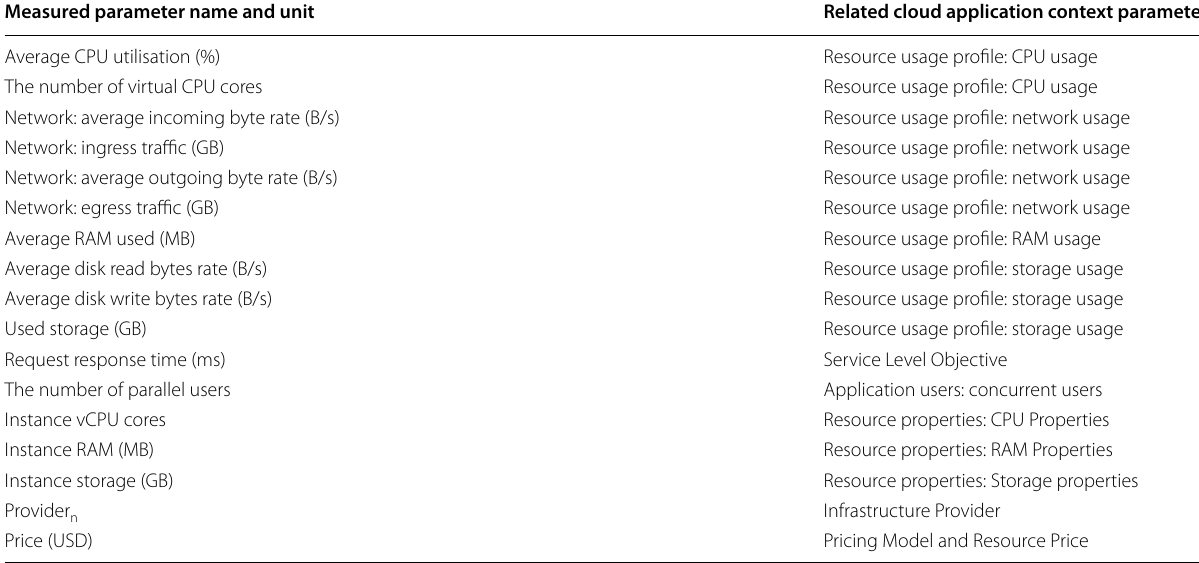
Table 4 Mapping of measured data and proposed cloud application context metamodel parameters Measured parameter name and unit Related cloud application context parameter Average CPU utilisation (%)